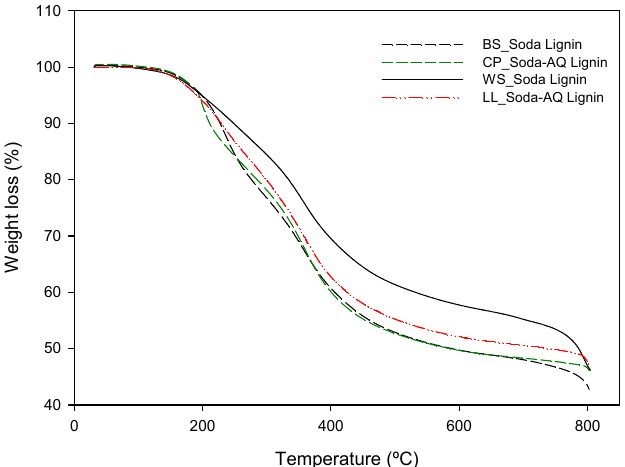
Figure 2. Thermogravimetric (TG) curves of lignin samples obtained from a thermogravimetric analysis (TGA). BS_Soda Lignin, CP_Soda-AQ Lignin, WS_Soda Lignin and LL_Soda-AQ Lignin refer to the lignin samples isolated from barley straw, Chamaecytisus proliferus , wheat straw and Leucaena leucocephala , respectively.